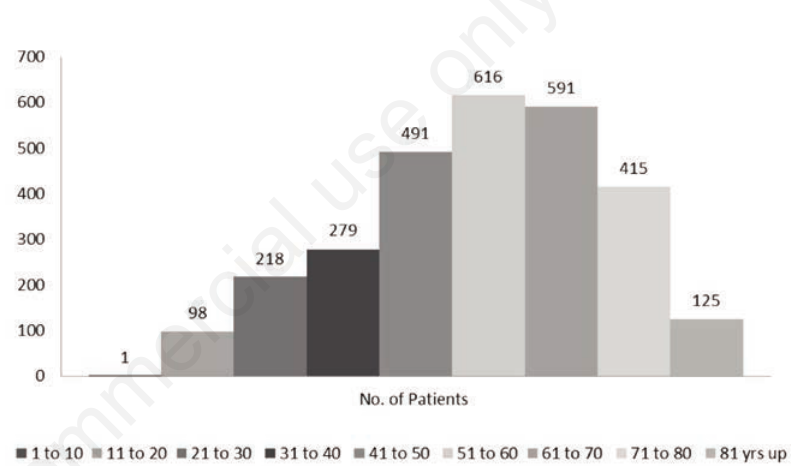
Figure 1. Age distribution of patients who attended the ambulatory neurology clinic dur- ing the study period.